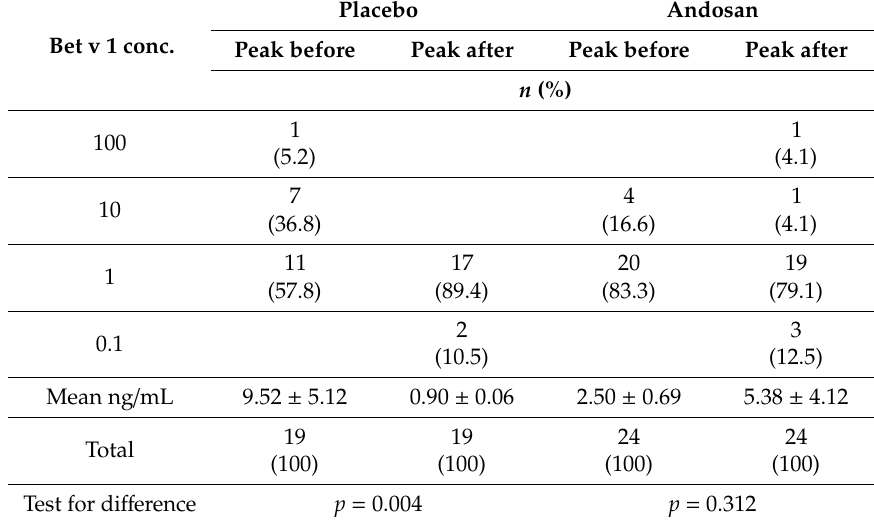
Table 4. Comparisons before and after intervention of maximal (peak) Bet v 1 concentration needed for basophil activation. Placebo Andosan Bet v 1 conc. Peak before Peak after Peak before Peak after n (%) 100